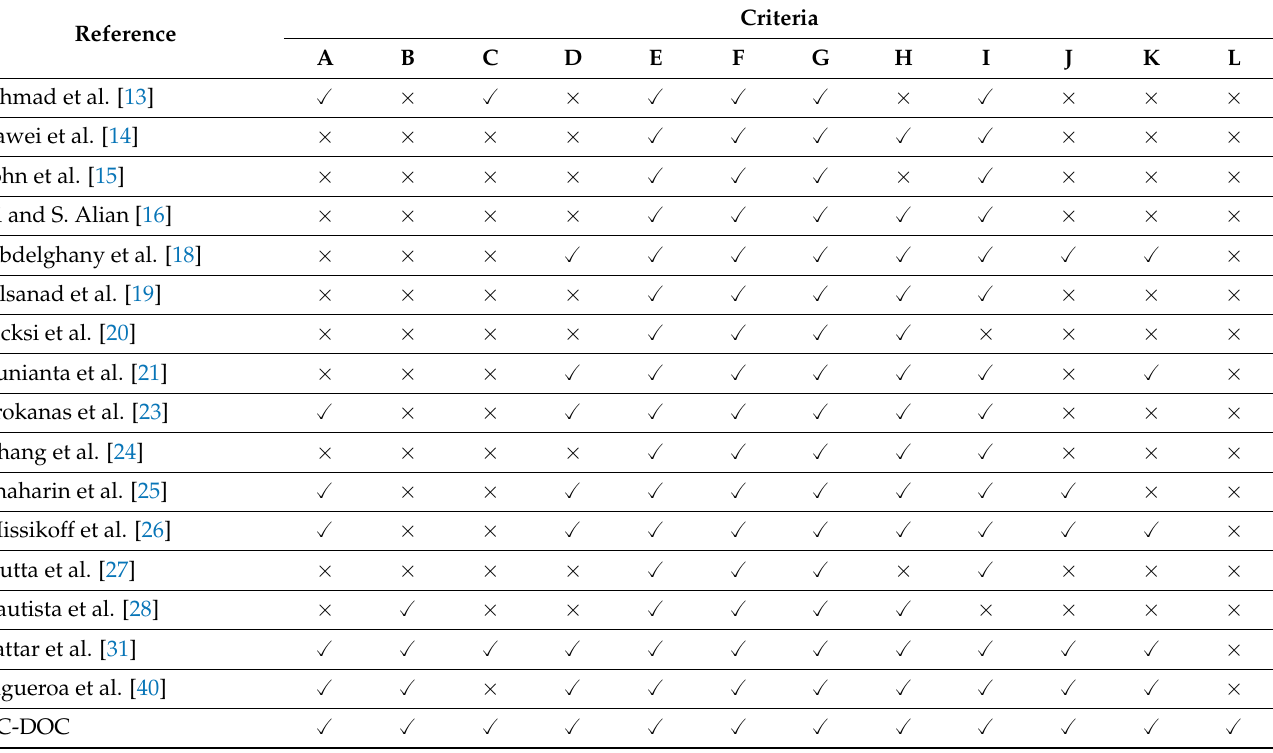
Table 1. A comparative study of domain ontology construction